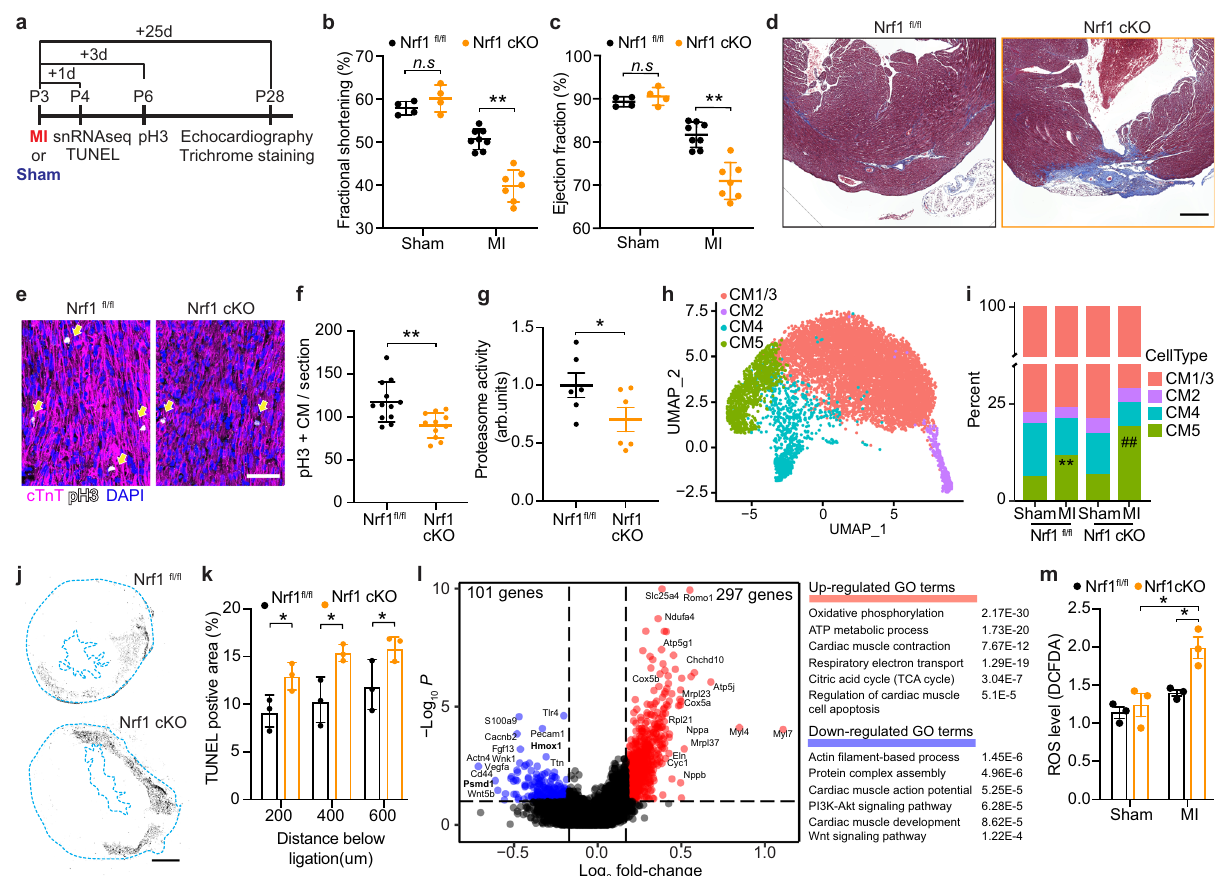
Fig. 2 Nrf1 deletion impairs neonatal heart regeneration. a Illustration showing timeline of MI and Sham surgeries performed at P3 and subsequent days of sample collection. b , c Fractional shortening ( b ) and ejection fraction ( c ) of Nrf1 fl / fl and Nrf1 cKO mouse hearts at 25 days after MI or Sham surgery; n = 4 animals for Sham groups and n = 7 – 8 animals for MI groups; ** p = 0.0022 ( b ), ** p = 0.0009 ( c ) by Student ’ s t -test two-tailed. d Masson ’ s trichrome staining showing fi brotic scarring in Nrf1 fl / fl and Nrf1 cKO mouse hearts at 25-day after MI; similar results were observed in six animals; Scale bar, 200 μ m. e Immunohistochemistry showing pH3 + cardiomyocytes (cTnT + ), marked by arrows, in heart sections collected from Nrf1 cKO and Nrf1 fl / fl mice 3-day post-MI; Scale bar, 50 μ m. f Quanti fi cation of pH3 + cardiomyocytes (cTnT + ) in heart sections from ( e ); n = 12 animals for WT and n = 11 animals for Nrf1 cKO, ** p = 0.0034 by Student ’ s t -test two-tailed. g Chymotrypsin-like activity of the proteasome in hearts from Nrf1 cKO and Nrf1 fl / fl mice at P4. arb. units, arbitrary units; n = 6 animals for each group; * p = 0.0373 by Student ’ s t -test one-tailed. h UMAP visualization of cardiomyocyte clusters colored by identity. CM1 and CM3 were merged as a single cluster due to their transcriptome similarity. i Fraction of cardiomyocyte populations in Nrf1 fl / fl and Nrf1 cKO hearts in MI or Sham conditions; n = 4 – 6 animals for each group examined over 1 independent experiment; ** p = 4.49E − 16 compared to WT- Sham, ## p = 5.05E − 31 compared to KO-Sham; Chi-squared test. j Representative images showing TUNEL staining on heart sections from Nrf1 cKO and Nrf1 fl / fl mice at 1-day post-MI; Scale bar, 500 μ m. k Quanti fi cation of TUNEL positive area in heart sections collected at 200, 400, and 600 μ m below the ligation from Nrf1 cKO and Nrf1 fl / fl mice at 1-day post-MI; n = 3 animals for each group; * p = 0.039 (200 μ m); p = 0.025 (400 μ m), p = 0.047 (600 μ m), Student ’ s t -test two-tailed. l Volcano plot showing fold-change and p -value of genes up-regulated (red) and down-regulated (blue) in CM4 cells of Nrf1 KO hearts compared to CM4 cells in control hearts at 1-day post-MI; p -adjust < 0.1 and fold-change > 1.5 were used for cutoffs; p -adjust values are calculated by Wilcoxon rank-sum test two-tailed. Top enriched GO terms are shown (right). m Quanti fi cation of ROS levels in Nrf1 cKO and Nrf1 fl / fl mice at 3-day post-MI or Sham; n = 3 animals for each group. WT-MI vs Nrf1 cKO-MI, * p = 0.015; Nrf1 cKO-Sham vs. Nrf1 cKO-MI, * p = 0.022, by Student ’ s t -test two- tailed. b , c , f , g , k , m results are shown as mean ± s.e.m.; n.s. not signi fi